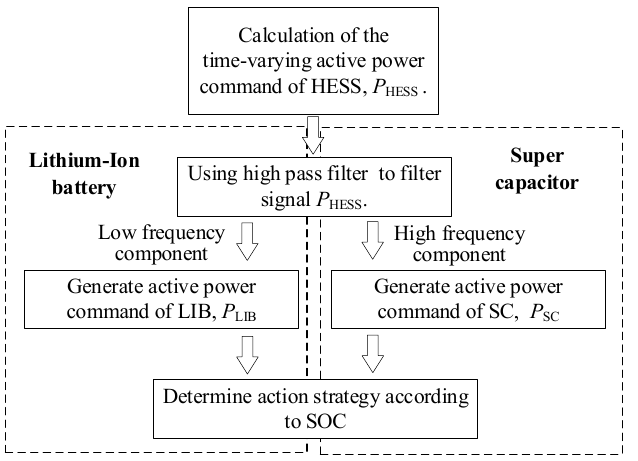
Figure 9. The schematic diagram of the proposed HESS-based auxiliary control strategy.